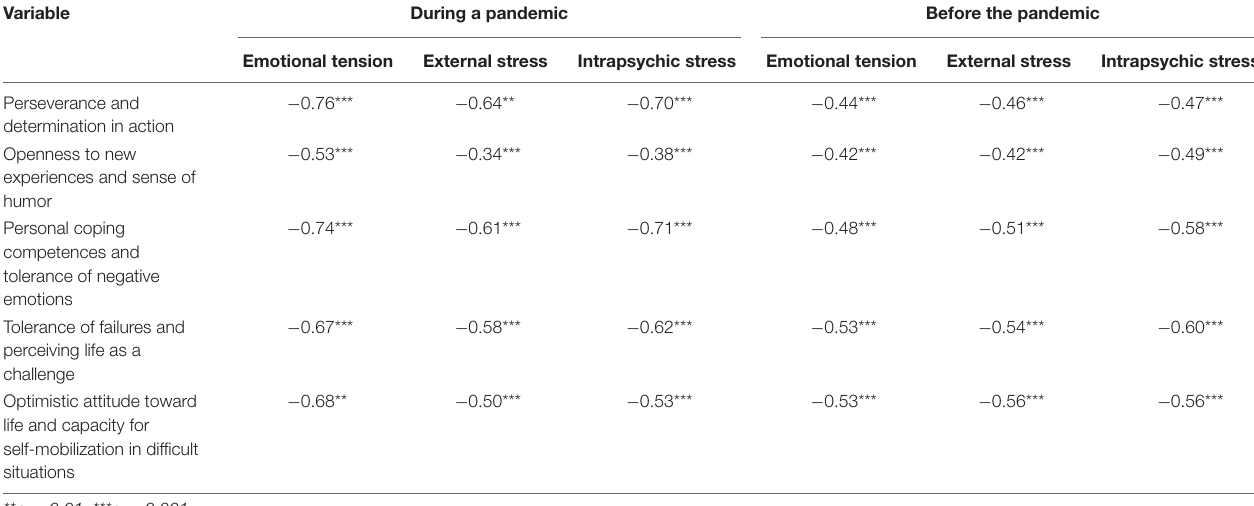
TABLE 2 | Pearson’s r correlations between stress and resilience dimensions among paramedics before and during the COVID-19 pandemic. Variable During a pandemic Before the pandemic Emotional tension External stress Intrapsychic stress Emotional tension External stress